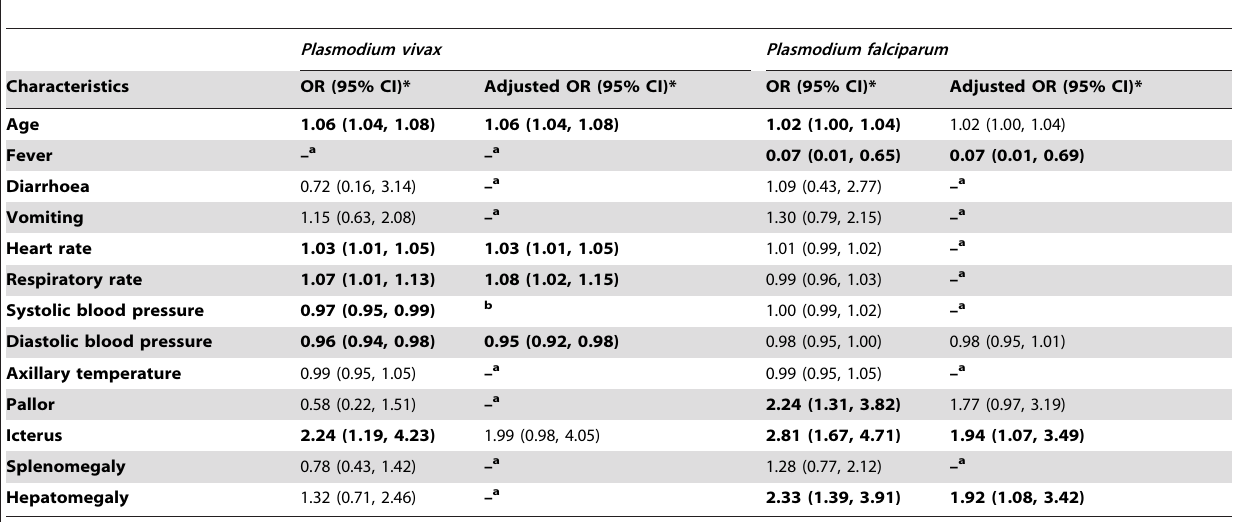
Table 7. Univariate and Multivariate Analysis for History and Physical Examination Factors Associated with AKI by Malaria Species.